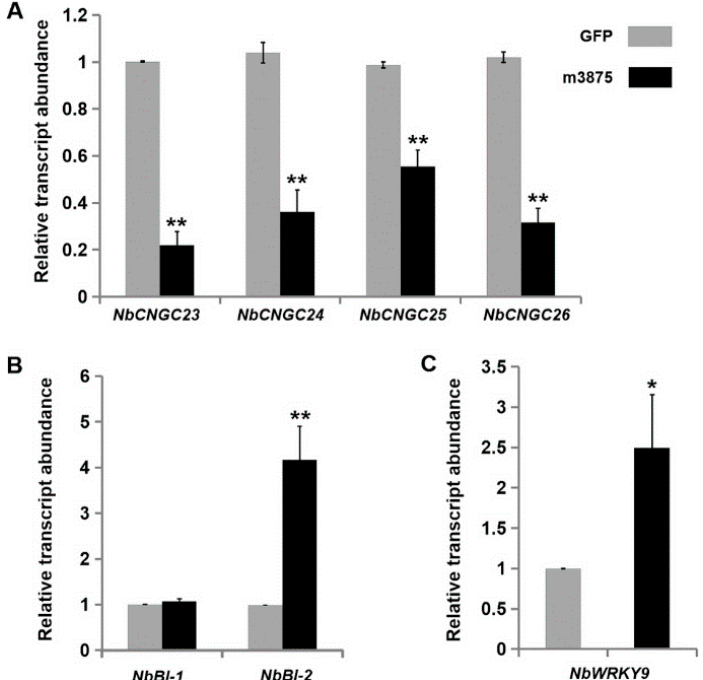
Figure 6. Effect of m3875 on the regulation of the defense-associated genes in Nicotiana benthamiana . Total RNA was extracted from the leaves that transiently expressed m3875 or GFP at 48 h post inoculation (hpi) and used to measure the relative expression levels of NbCNGC23 , NbCNGC24 , NbCNGC25 , NbCNGC26 ( A ), NbBI-1 , NbBI-2 ( B ), and NbWRKY9 ( C ) using RT-qPCR. Three biological replicates (each consisting of three technical replicates) were performed. Expression levels of the indicated genes were individually normalized to the internal reference Nbactin . Bars represent the mean ± standard error, and asterisks denote significant differences according to a Student’s t test (** p < 0.01 and * p < 0.05).